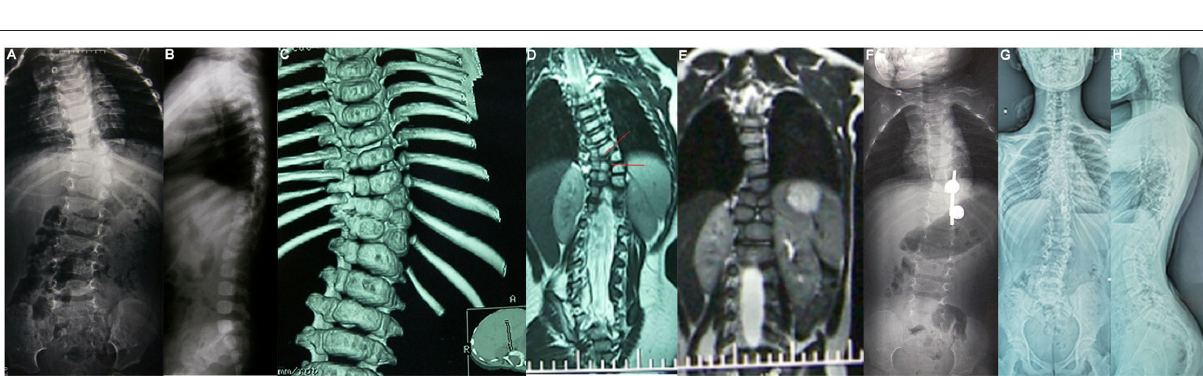
FIGURE 3 | Female aged 11 years, L5–S1 hemivertebra, lumbosacral kyphosis, due to the poor development of the pedicle of the right vertebral body of L4-6, the Schwab grade 6 osteotomy of the left hemivertebral body between L5S1 and the internal fixation of the left L4, L5, S1 and S2 screw rods were performed. Preoperative x-ray [ (A) coronal position, (B) sagittal position] and computed tomography (CT) (C,D) , CT and X-rays after surgery (E,F) .